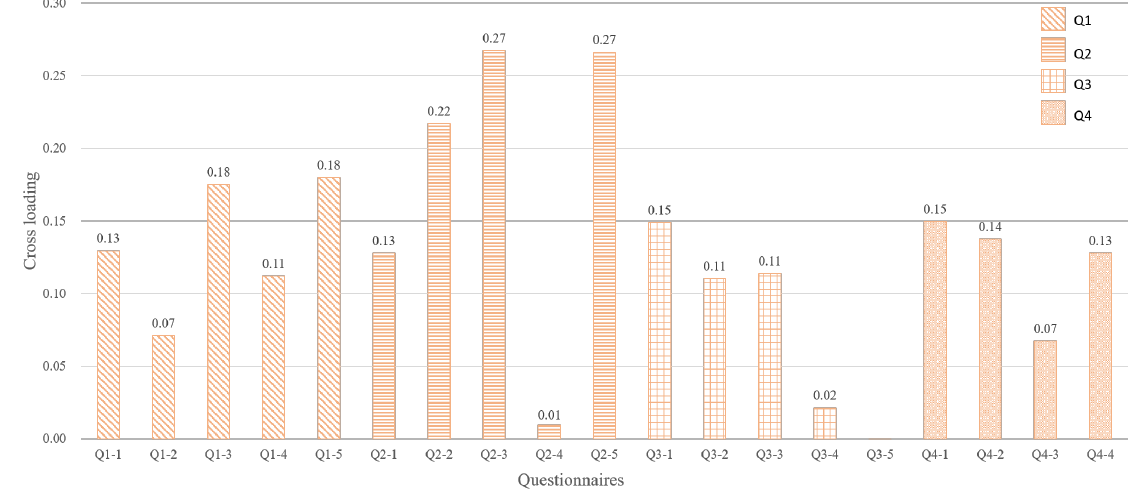
Figure 6. Cross-loading of “brain activity and questionnaires”